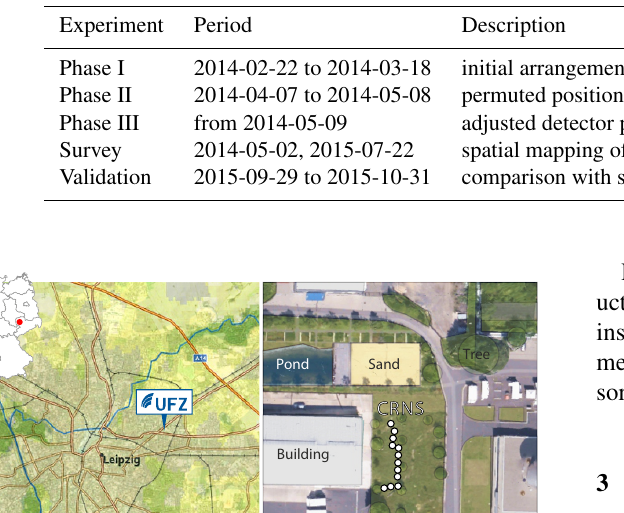
Table 2. Measurement strategy to investigate the sensor-to-sensor variability (Phase I), the influence of location (Phase II), the effects of detector parameters (Phase III), the heterogeneity of neutrons within the sensor’s footprint (Survey), and the sensor’s capabilities to monitor soil moisture in the complex, urban terrain.